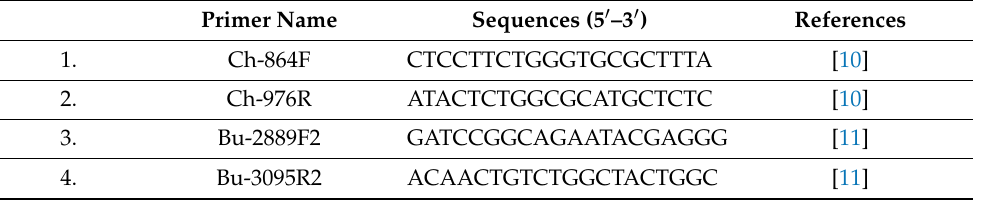
Table 1. Primers used to detect Chequa iflavirus (Ch) and Athtab bunyavirus (Bu) using